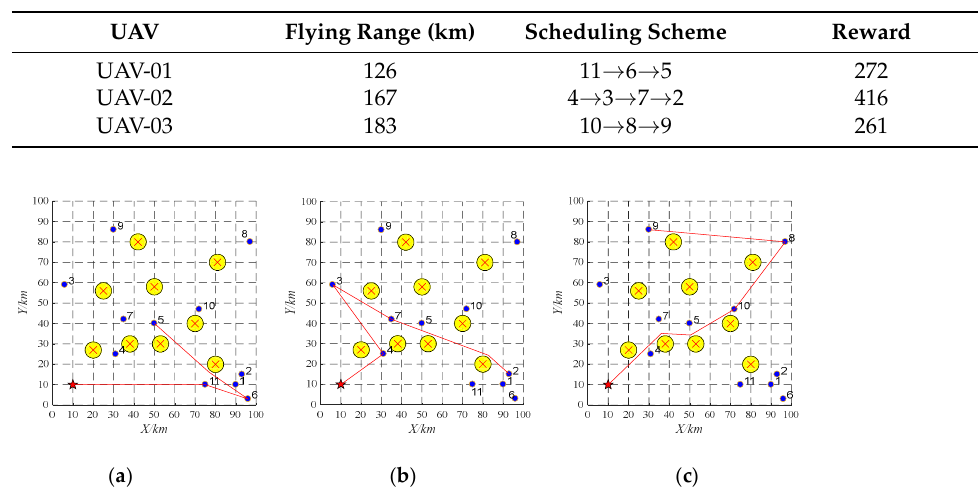
Figure 11. Task re-scheduling schemes with the pop-up obstacle based on replacement contract. ( a ) UAV-01; ( b ) UAV-02; ( c ) UAV-03. Table 11. Task Rescheduling Schemes based on Buy-sell Contract to Deal with Pop-up Obstacles.